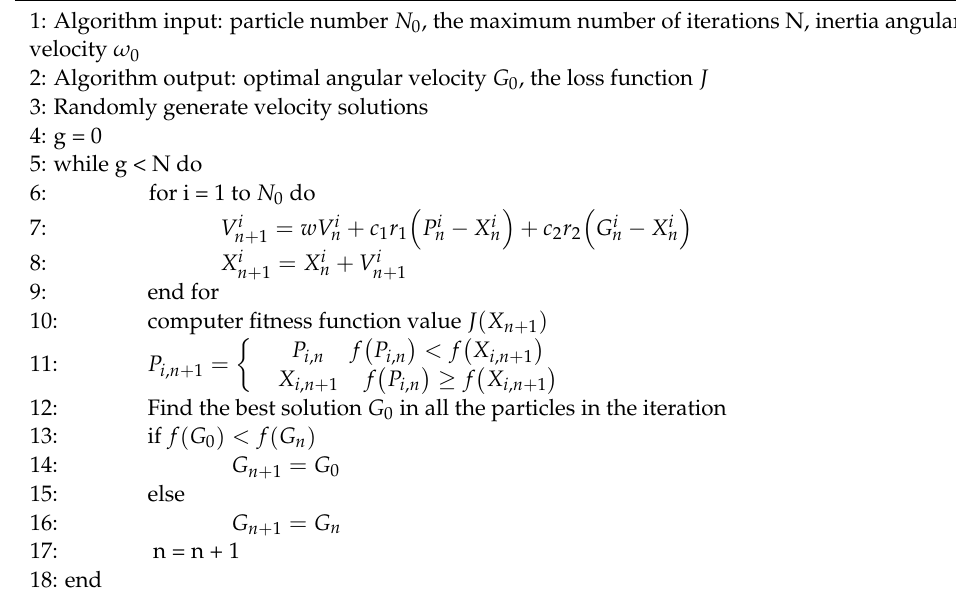
Algorithm 1 Standard PSO pseudocode